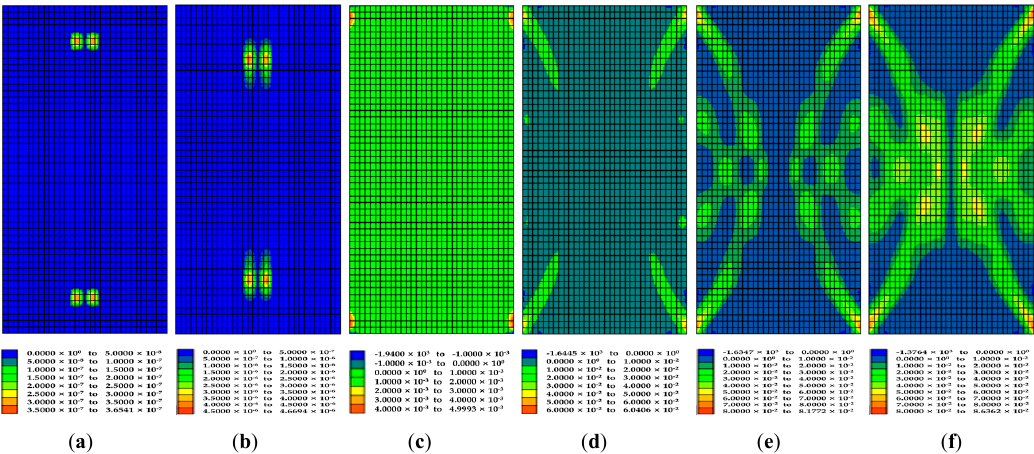
Figure 12. Cloud pictures of the permeability coefficient distribution of model specimen cross section at ( a ) 400, ( b ) 900, ( c ) 1400, ( d ) 1900, ( e ) 2400, and ( f ) 2900 steps.